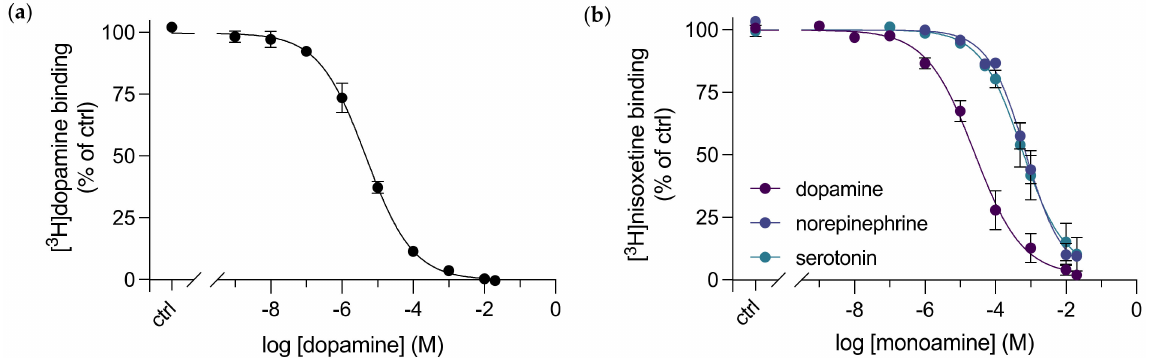
Figure 3. Binding of monoamine neurotransmitters to purified dDAT. ( a ) Homologous competitive binding of dopamine to purified dDAT. Dopamine K d = 4.4 [3.4; 5.6] µ M for dopamine binding to dDAT, n = 3 from 2 independent dDAT-SBP-His 10 purifications, performed in triplicates. ( b ) Com- petitive inhibition of [ 3 H]nisoxetine binding to purified dDAT by unlabelled dopamine (purple), norepinephrine (blue) and serotonin (green). The K i values determined are as follows: 6.9 [4.5; 10.5] µ M for dopamine, 184 [141; 239] µ M for norepinephrine and 173 [97; 311] µ M for serotonin. n = 3 from 2 independent dDAT-SBP-His 10 purifications, performed in triplicates. Data are shown as mean ± SEM. ctrl (control): [ 3 H]nisoxetine binding in the absence of the competitive